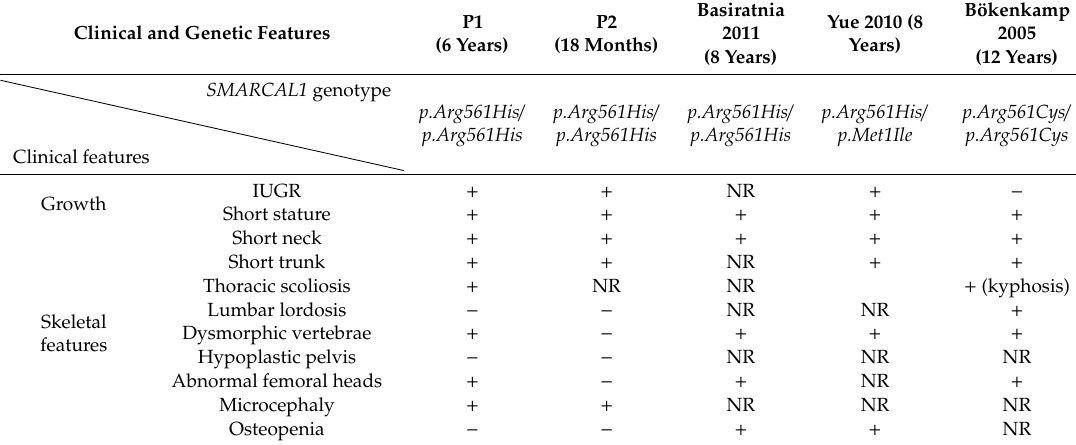
Table 1. Comparison of clinical features among the two siblings and previously-published cases with at least one mutation involving the same SMARCAL1 residue (p.Arg561).